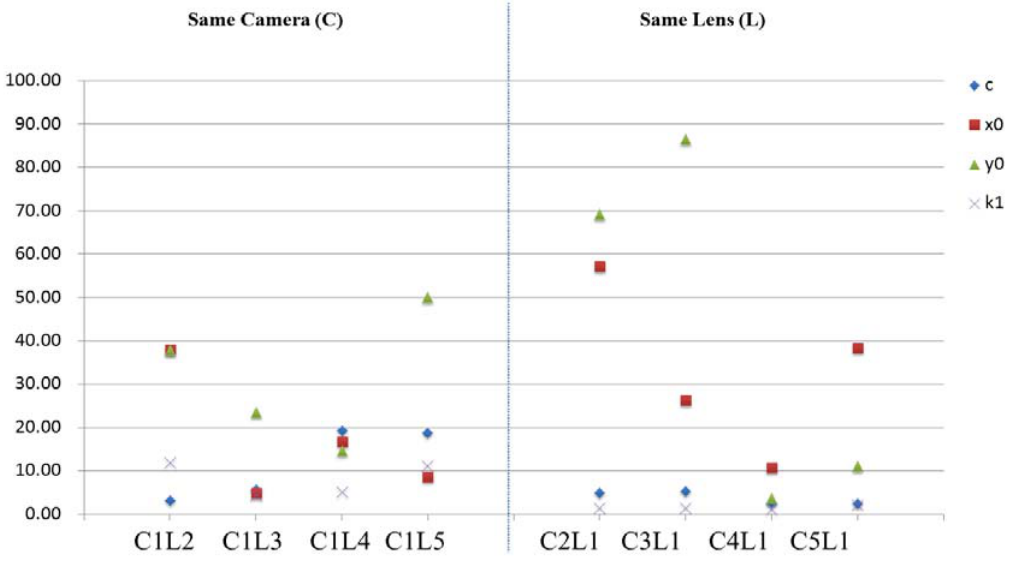
Figure 9. Stability analysis combining five SONY A850 cameras with five 50 mm lenses.